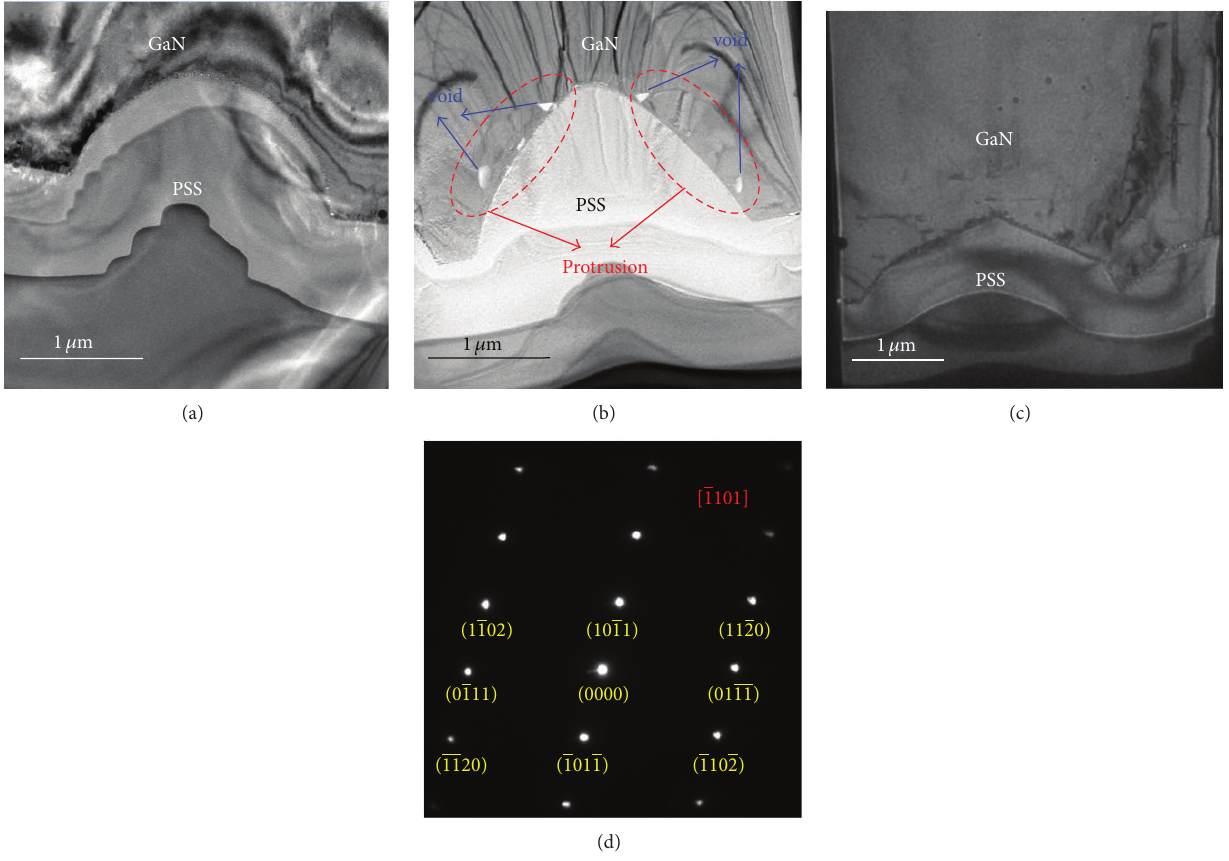
Figure 3: Cross-sectional TEM images of the GaN epilayers grown on the PSSs subjected to wet etching for (a) 0min, (b) 3 min, and (c) 10min. (d) Selected area electron diffraction pattern of the right protrusion in